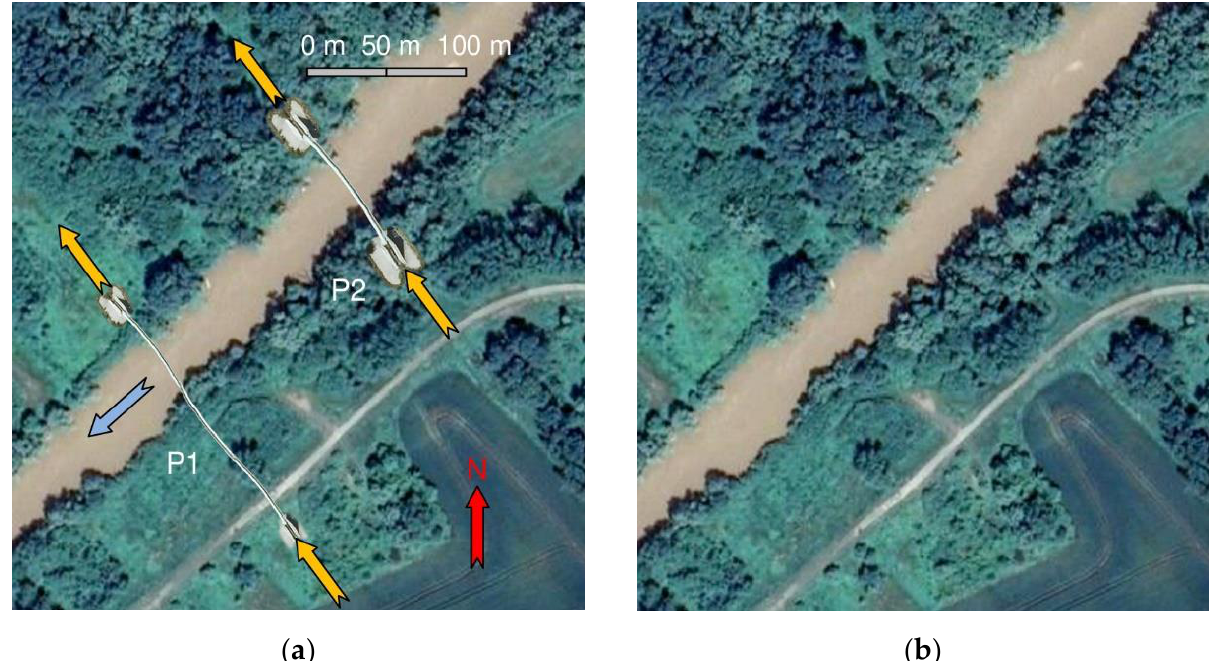
Figure 14. ( a ) Original gas pipeline bridges P1 and P2 over the Laborec river, ( b ) Current underground solution for crossing all 4 branches of the gas pipeline (the blue arrow indicates the direction of water flow, the yellow arrows indicate the direction of gas flow in the pipe, and the red arrow indicates north).